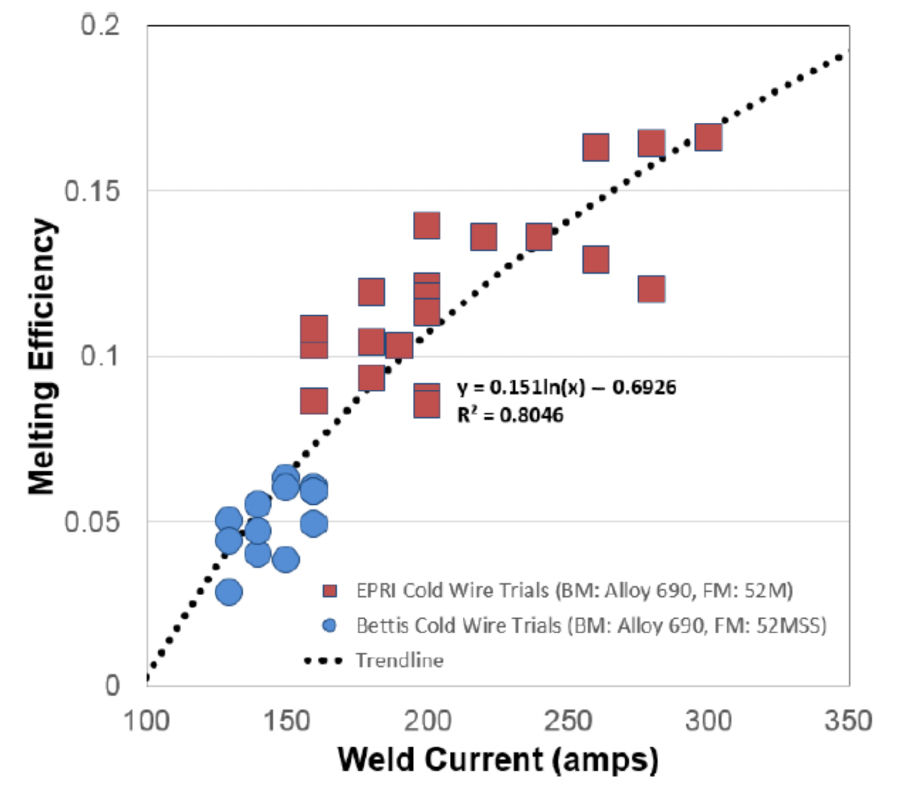
Figure 3. Relationship between the welding current and base metal melting efficiency summarized by EPRI